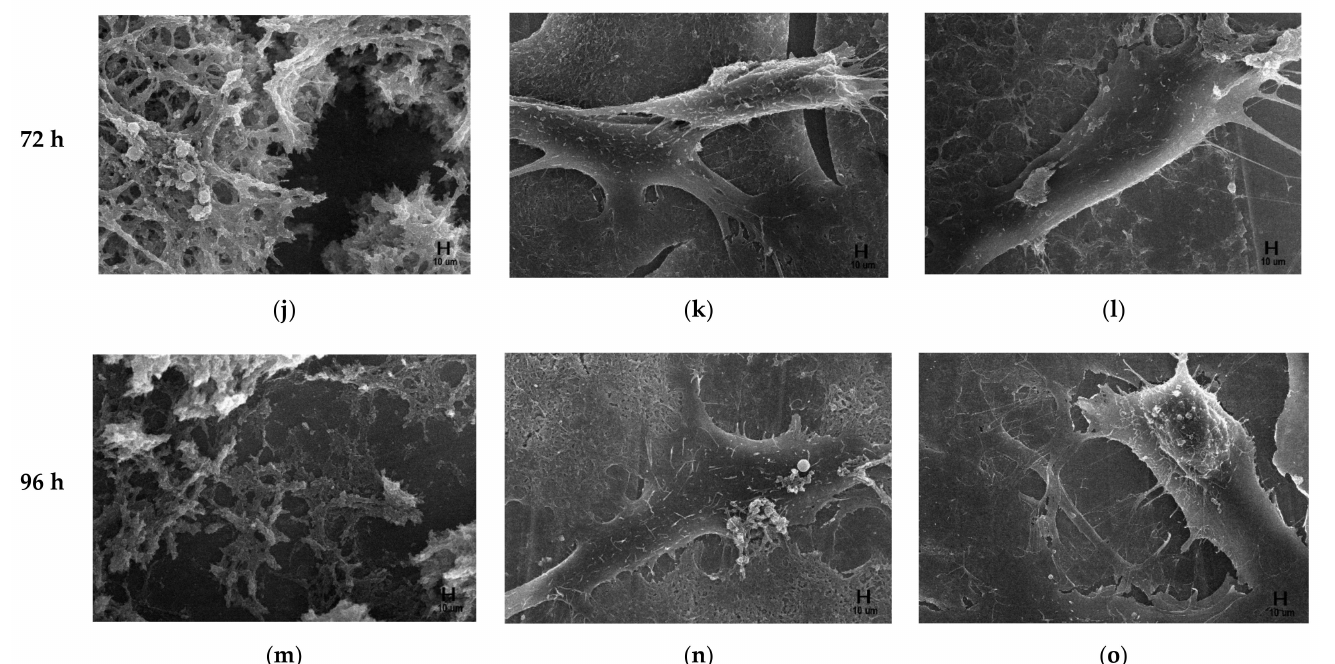
Figure 9. Field emission-scanning electron microscopy images of osteoblastic-like MC3T3-E1 cells cultured after 0 h ( a – c ) ( × 5000), 24 h ( d – f ), 48 h ( g – i ), 72 h ( j – l ), and 96 h ( m – o ) ( × 3000) on contaminated zirconia